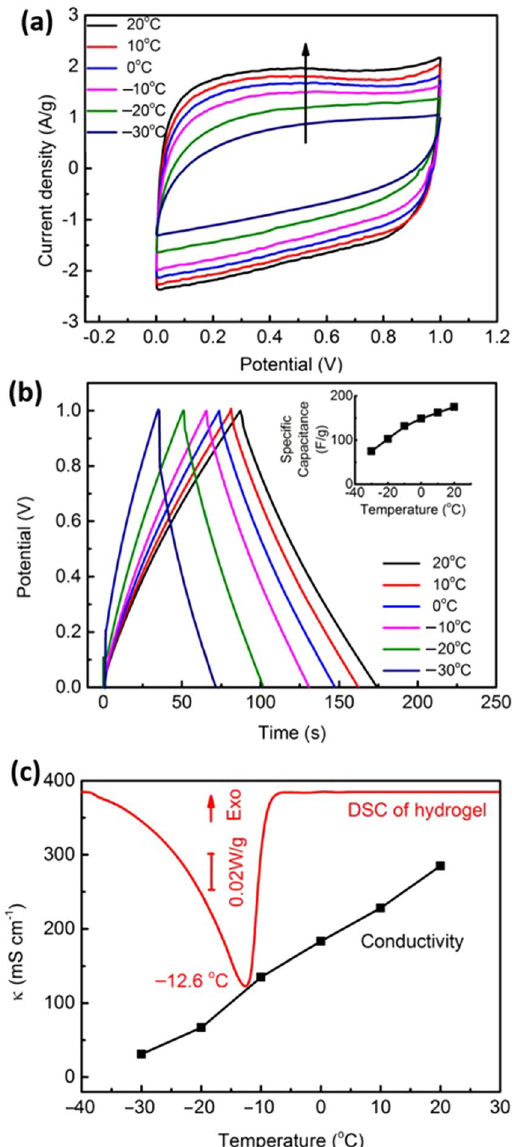
Figure 5. ( a ) Fabricated supercapacitor (SC-PA) temperature dependence of cyclic voltammetry (CV) profiles at a scan rate of 20 mV s − 1 . The arrow indicates the direction of increasing temperatures. ( b ) Galvanostatic charging–discharging (GCD) profiles at a current density of 1 A g − 1 . The inset indicates calculated specific capacitance with respect to temperature change. ( c ) A differential scanning calorimetry (DSC) result of 3 M KOH-containing polyampholyte hydrogel with increasing temperature compared with the change in conductivity as a function of